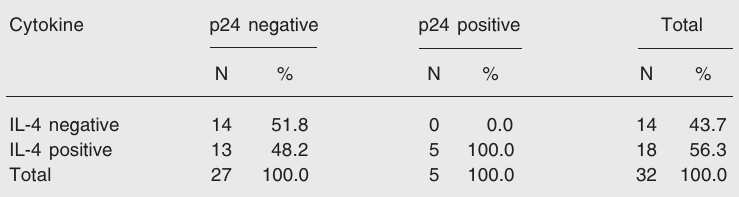
Figure 4. Comparison of mu- cosal CD45RO+ T lymphocyte (TL) count between mucosal p24-positive (N = 6) and -nega- tive patients (N = 28). Mann- Whitney: P = 0.03. Only indi- viduals from groups 2 and 3 were analyzed. The boxplots show the minimum/maximum value, 1st and 3rd quartiles and